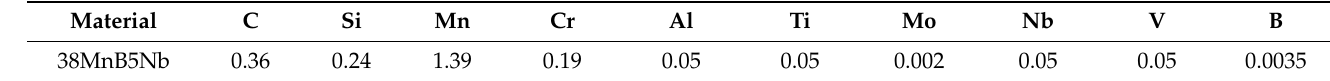
Table 1. Chemical compositions of as-received 38MnB5Nb steel (mass%).